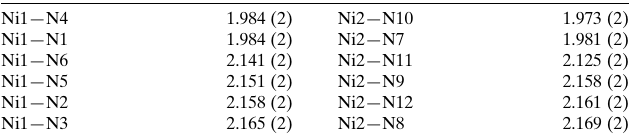
Selected bond lengths (A˚